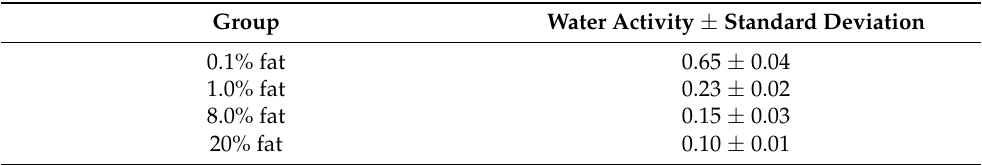
Figure 5. Lipid hydroperoxide formation in crackers with different fat contents at 55 ◦ C. Data points are the average of 3 measurements ± standard deviations. Table 2. Water activity of crackers with varying fat content at room temperature. Data points are the average of 3 measurements ± standard